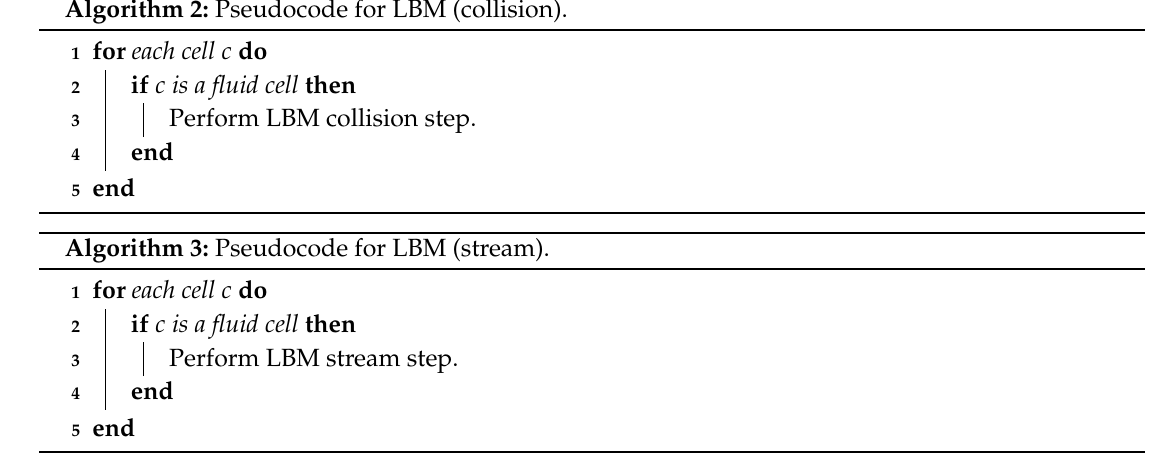
Algorithm 2: Pseudocode for LBM (collision).